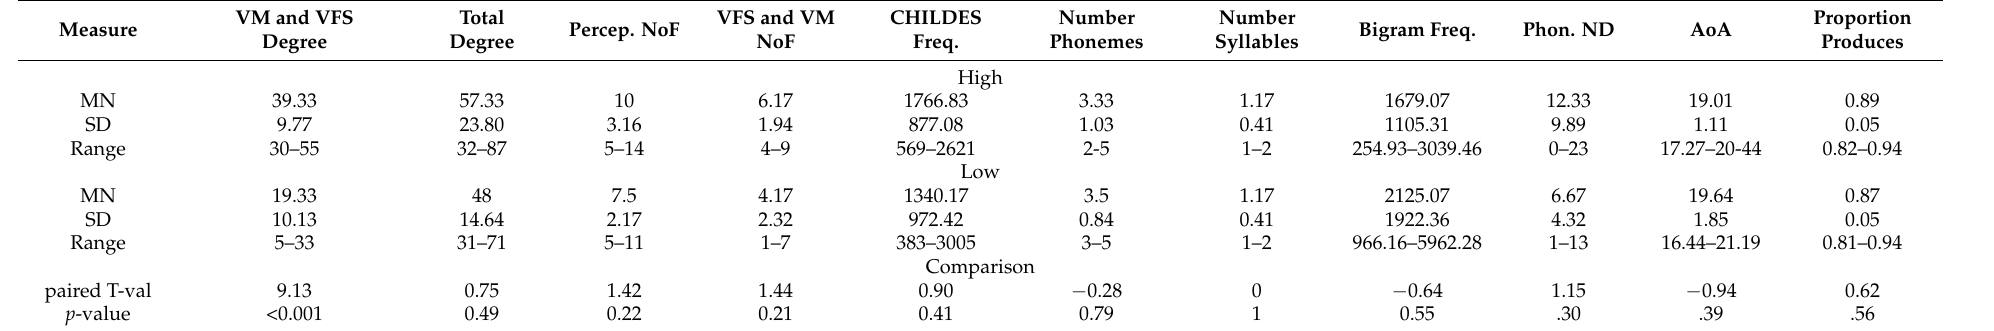
Table A2. Group-level statistics and comparisons of experimental